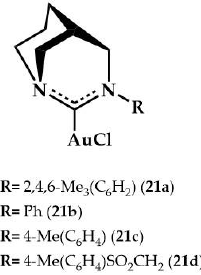
Figure 8. Gold complexes with anti-Bredt ligands.